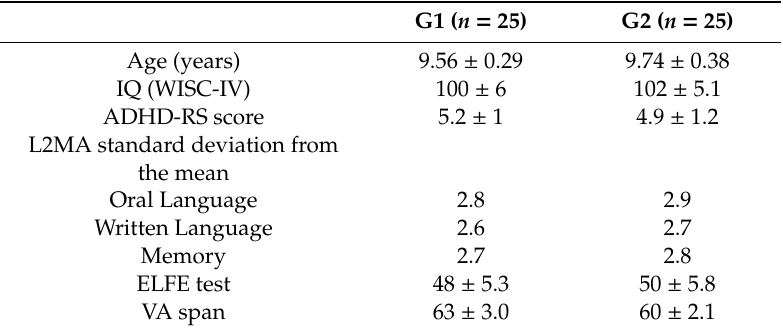
Table 1. Clinical characteristics of the two groups of dyslexic children (G1 = experimental group; G2 = control group) with mean and standard deviations of age (years), IQ, of words/min read in the ELFE test and visual attentional span test (the number of letters accurately reported across the trials).